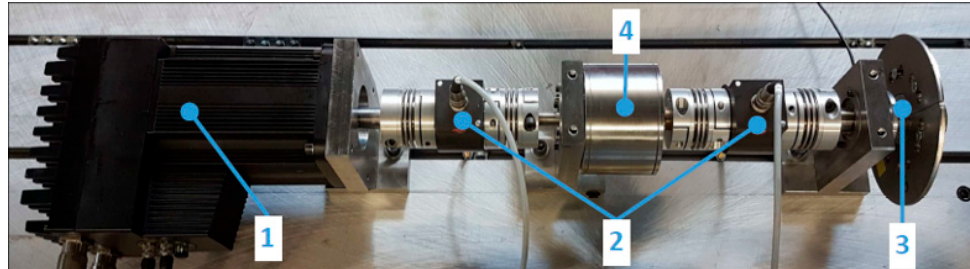
Figure 7. Experimental test rig consisting of a (1) position controlled PMSM, (2) torque sensors, (3) flywheel—load and the developed prototype of a magnetic spring (4).